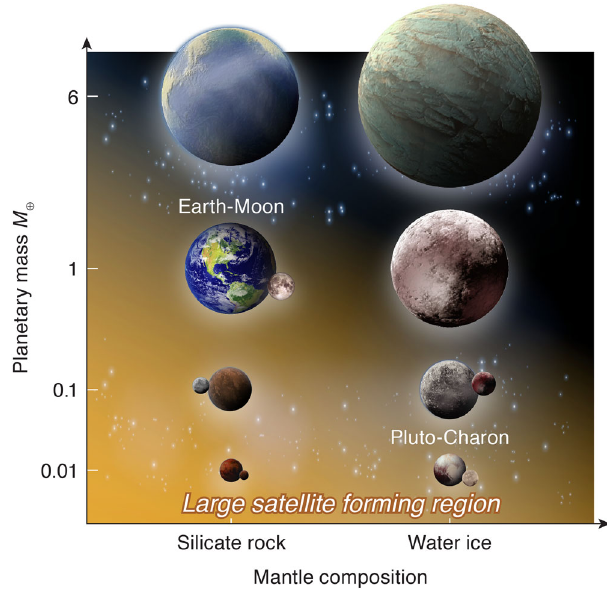
Fig. 6 Schematic view of the mass range in which a fractionally large exomoon can form by an impact. The horizontal axis represents the mantle composition and the vertical axis represents the planetary mass normalized by the Earth mass M ⊕ . Rocky planets smaller than 6 M ⊕ and icy planets smaller than 1 M ⊕ are capable of forming fractionally large moons as indicated by the orange shading. Our prediction is consistent with planet – moon systems in the solar system.